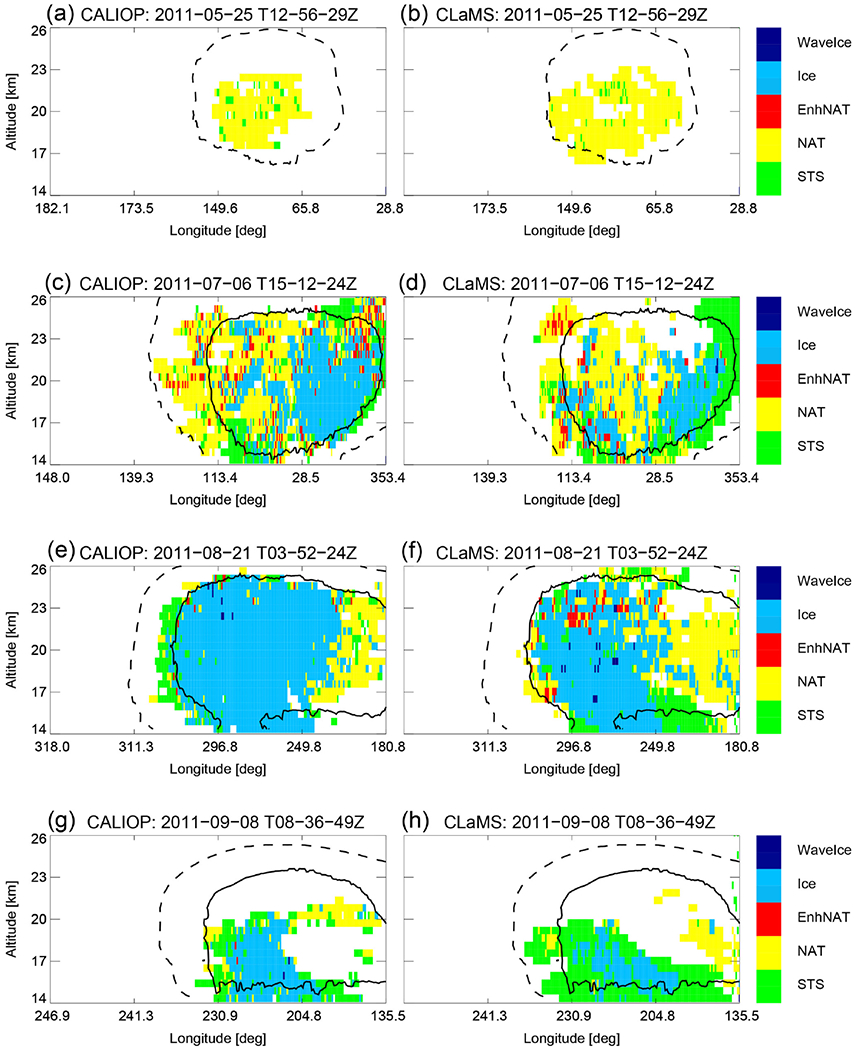
Same as first row in Figs. 3 and 7 but for 4 certain days in SH winter 2011: 25 May (2011-05-25T12-56-29Z, a, b), 6 July (2011-07-06T15-12-24Z, c, d), 21 August (2011-08-21T03-52-24Z, e, f), and 8 September (2011-09-08T08-36-49Z, g, h).